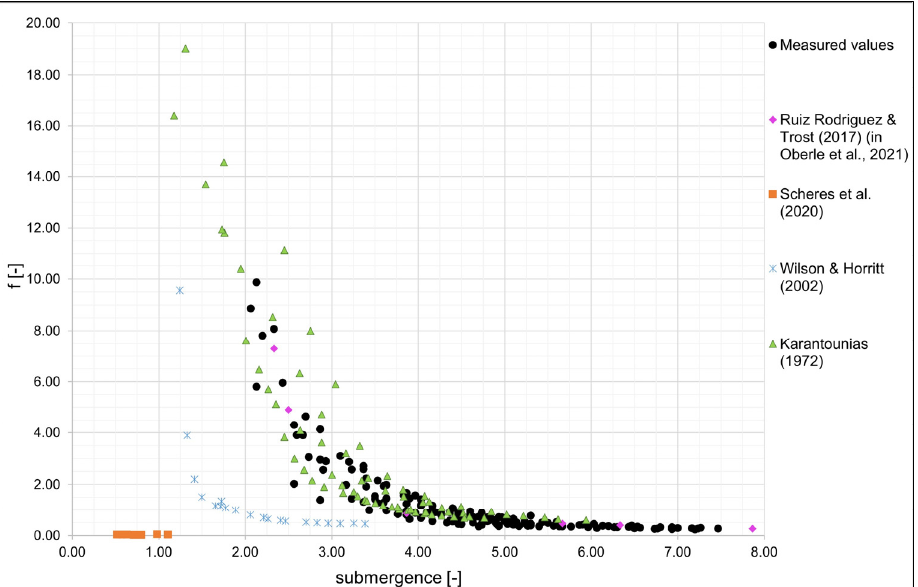
Figure 4. Relationship between relative submergence ( h / h veg ) and friction factor f . Measured values of this study (black dots) are compared to data from the literature.